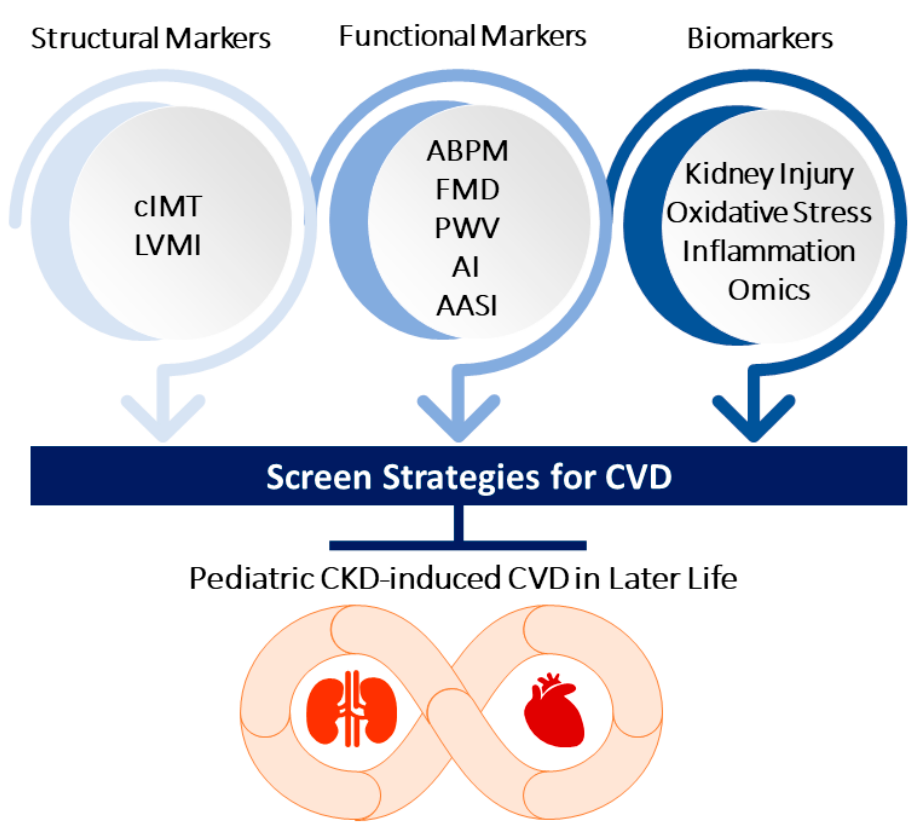
Figure 2. Screen strategies used for prevention of pediatric chronic kidney disease (CKD)-induced cardiovascular (CVD) include structural markers, functional markers, and biomarkers. cIMT = carotid intima-media thickness; LVMI = left ventricular mass index; ABPM = 24 h ambulatory BP monitoring; FMD = flow-mediated dilatation; PWV = pulse wave velocity; AI = augmentation index; AASI = ambulatory arterial stiffness index.